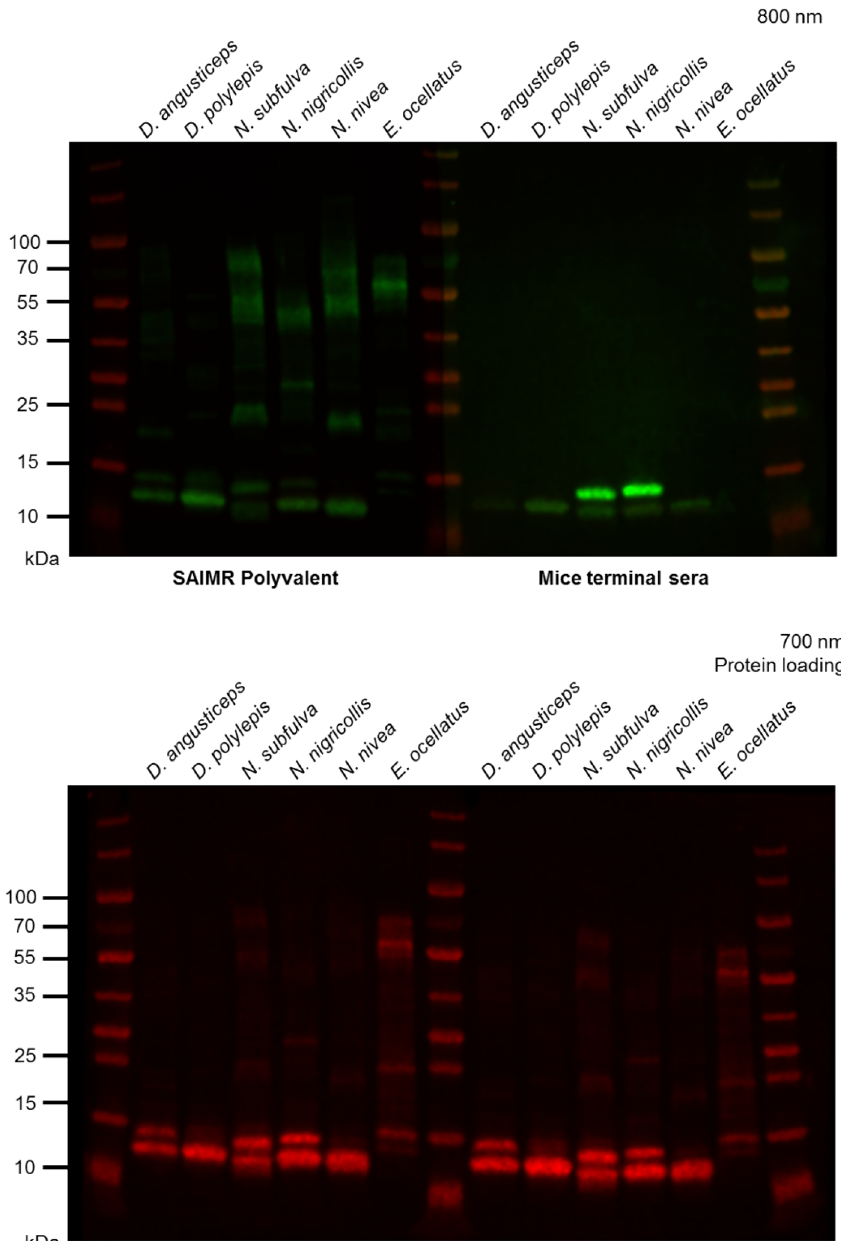
Figure 3. Immuno-blots for qualitative comparison of venom recognition by veVLP mice sera and SAIMR Polyvalent antivenom. Top: Immuno-blots of venoms probed with equal concentrations of SAIMR Polyvalent antivenom (left) or pooled veVLP (right), imaged at 800 nm for 2 min. Immuno-blots were performed and imaged concurrently. Venoms used from left to right were D. angusticeps , D. polylepis , N. subfulva , N. nigricollis , N. nivea and E. ocellatus. Bottom panel: Protein loading controls imaged in 700 nm channel for 2 min. Venoms were loaded onto one gel as shown in the bottom panel, which was cut in half for separate incubations with the different test sera or antivenom. The two halves were then imaged side-by-side for the final